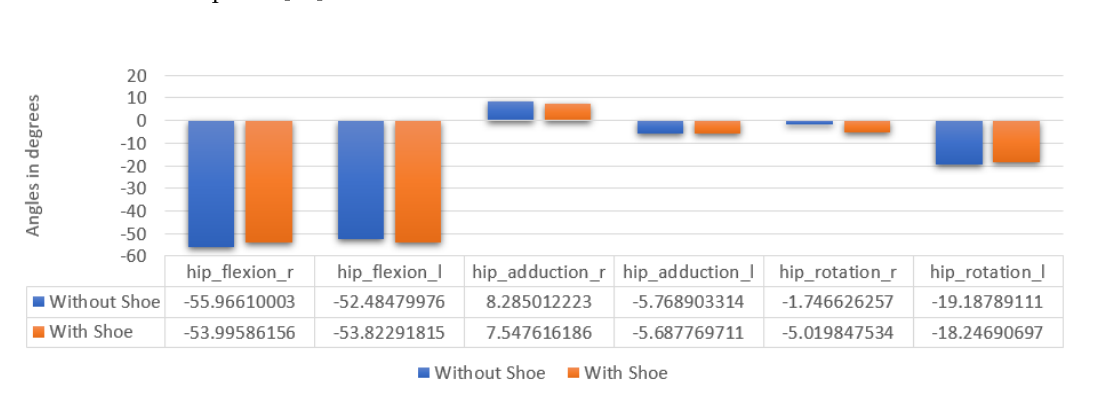
Figure 4. Maximum hip joint angles of flatfoot subjects with and without shoes. r-right; l-left. The knee angle of the flatfoot subjects and its maximum joint angle with and without shoes are depicted in Figures 5 and 6.